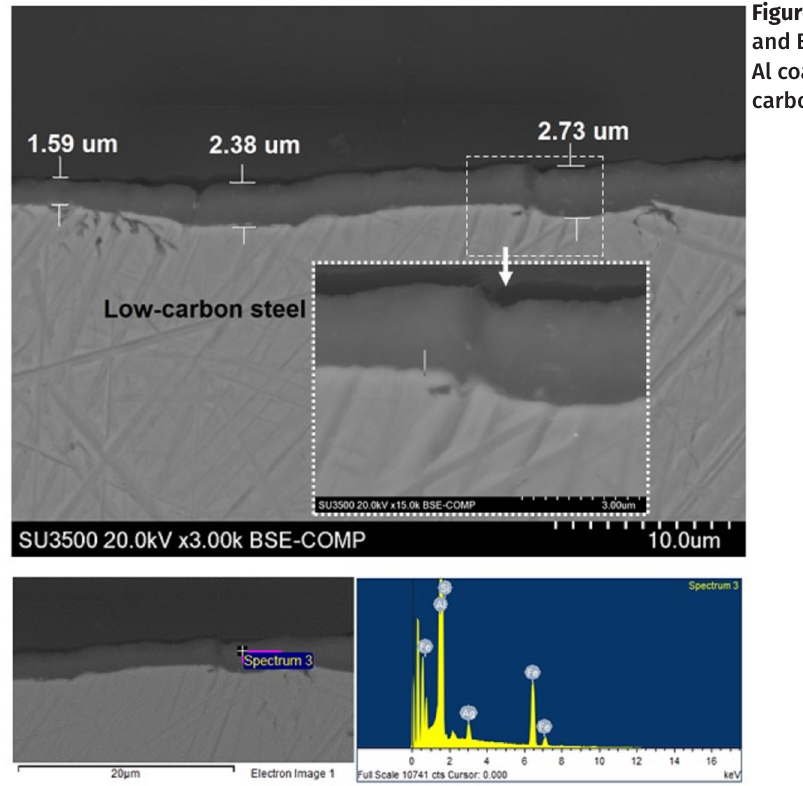
Figure 2. SEM images and EDX point area of Al coating on low- carbon